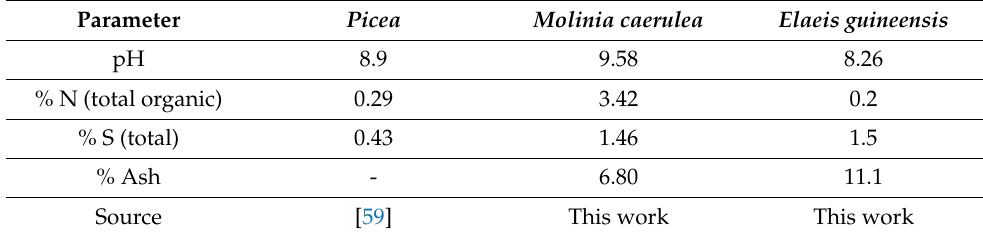
Table 1. Physicochemical characteristics of